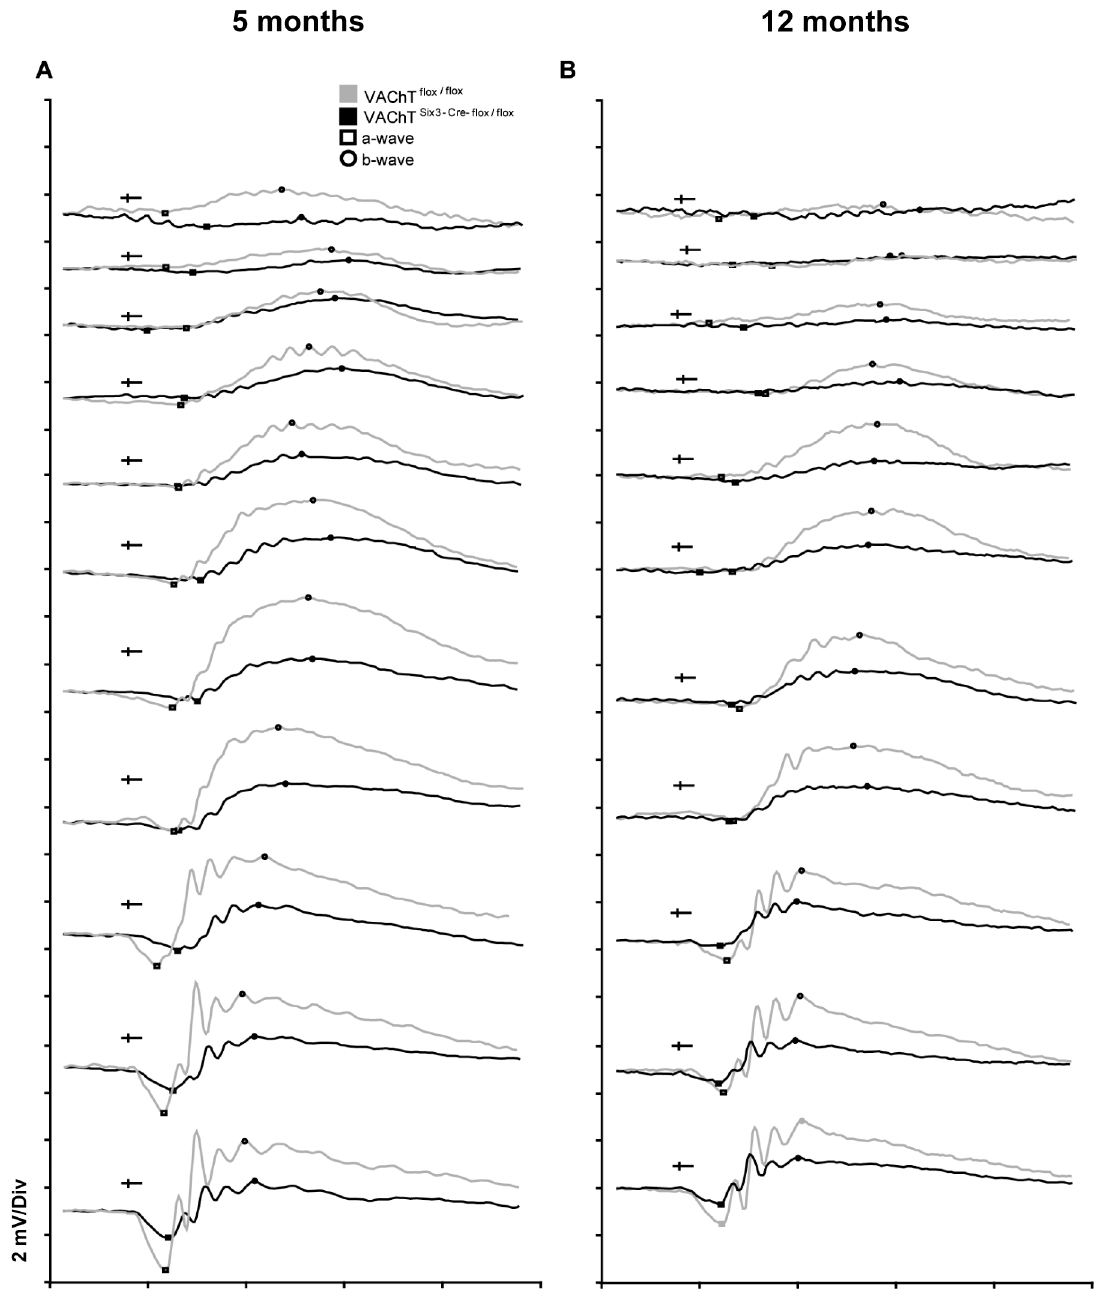
Fig 3. Characterization of retinal electrophysiology under scotopic conditions. Representative scotopic ERG traces for VAChT Six3-Cre-flox/flox and VAChT flox/flox littermate control mice at (A) 5 and (B) 12 months of age at eleven light stimuli of increasing strength. ERG waveforms assessed in response to 11 light stimuli of increasing luminance (0.001 to 25 cd+s/m 2 ). Waveforms are arranged from lowest stimulus luminance (top) to highest (bottom). Amplitudes of the a-wave (squares) and b-wave (circles) are reduced in VAChT Six3-Cre-flox/flox retinas relative to littermate controls, whereas implicit times of the a- and b- waves are unaffected by the loss of VAChT .; the stimulus onset is indicated by a sideways cross